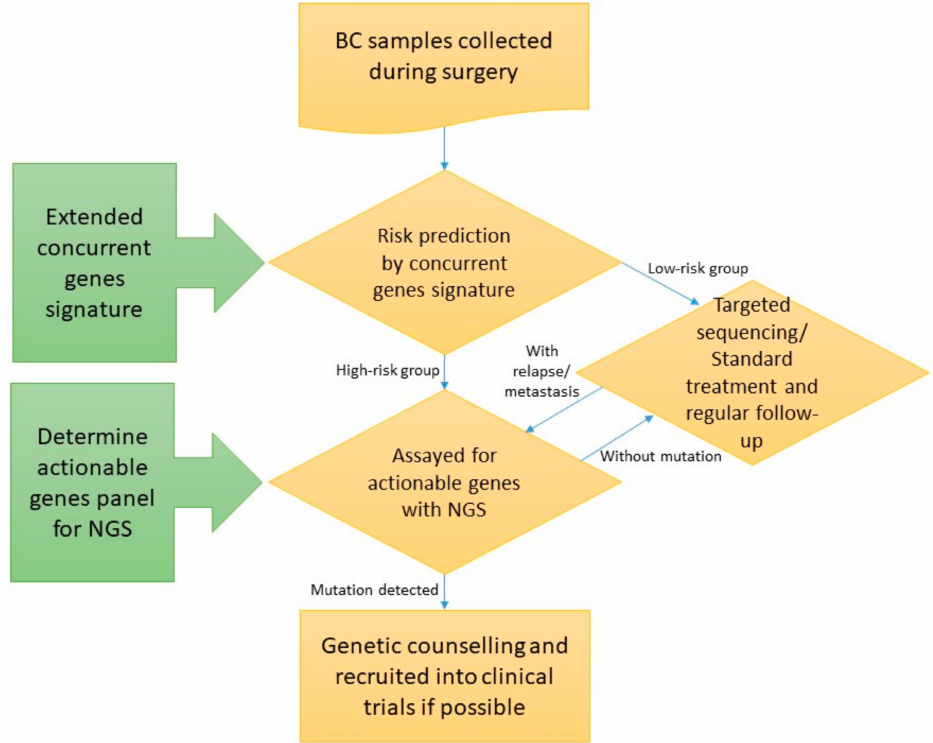
Figure 1. Schematic flow chart of the study (BC: Breast cancer; NGS: Next-generation sequencing). Enrolled subjects underwent targeted sequencing, and those who were also experimented with extended concurrent genes signature were predicted into high- and low-risk